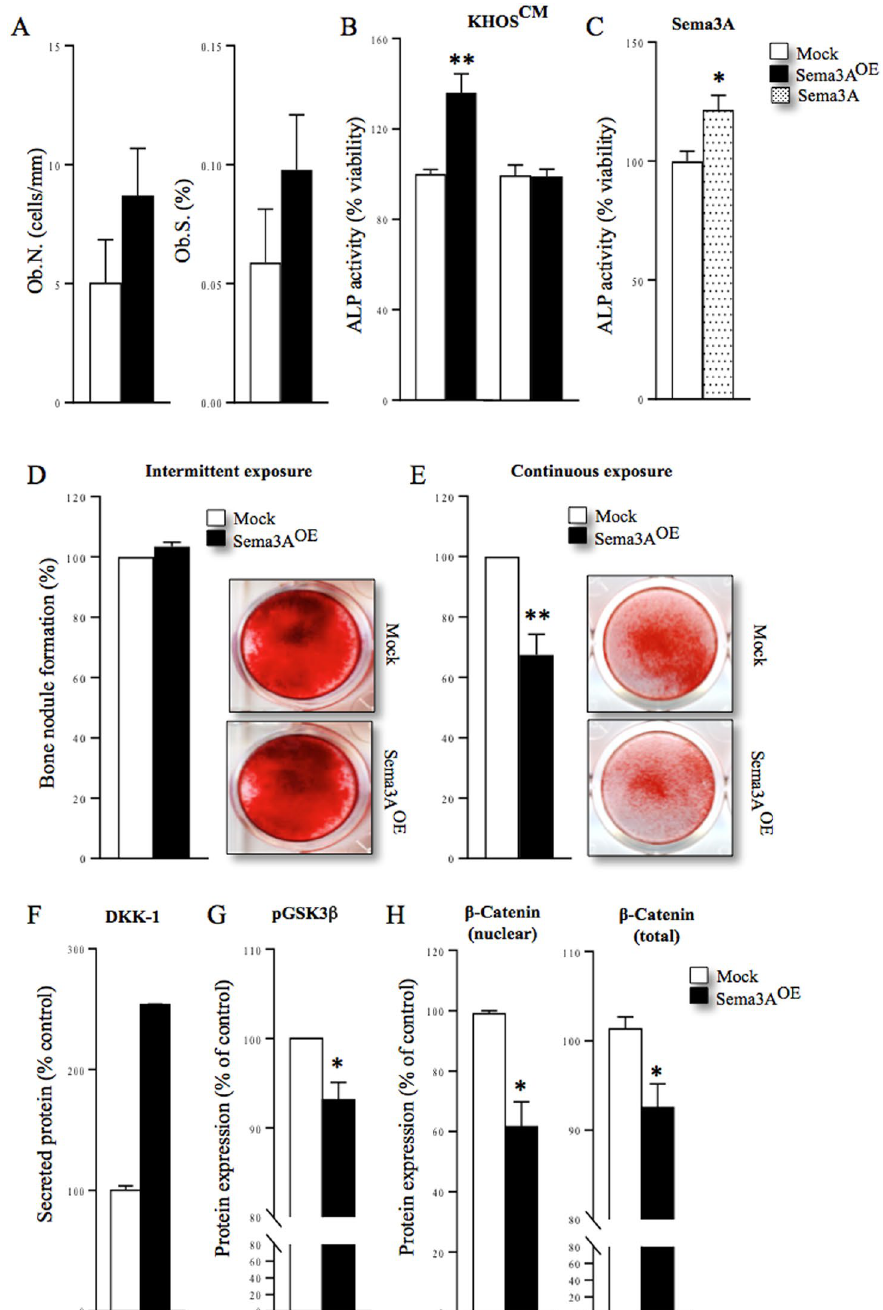
Figure 4. Bidirectional regulation of osteoblast differentiation by Sema3A. ( A ) In vivo osteoblast number (Ob.N) from tibial metaphysis from the mice of the experiment described in Fig. 3. ( B , C ) In vitro differentiation of Saos-2 after intermittent ( B , left) and continuous ( B , right) exposure to conditioned medium from human KHOS cells overexpressing Sema3A (Sema3A OE ) or Sema3A (300 ng/ml, C ) as assessed by alkaline phosphatase assay. In vitro bone nodule formation in Saos-2 after intermittent ( D ) and continuous ( E ) exposure to conditioned medium from human KHOS cells overexpressing Sema3A (Sema3A OE ) or their respective controls as assessed by Alazarin Red. Representative photomicrographs of bone nodule formation from the experiments described are shown in the right. ( F ) Levels of tumour derived osteoblast inhibitory factor, DKK1 in conditioned medium from human KHOS cells overexpressing Sema3A (Sema3A OE ) or their respective control measured by the Proteome Profiler Human XL Cytokine Array Kit. ( G ) Differential expression of p-GSK3 β after 15 minutes in the osteoblast-like MC3T3 cells exposed to conditioned medium from human KHOS cells overexpressing Sema3A (KHOS OE ) or their respective control (mock). ( H ) Differential expression of nuclear β -catenin (left) after 45 minutes and total β -catenin (right) after 24 hours in the osteoblast-like MC3T3 cells exposed to conditioned medium from human KHOS cells overexpressing Sema3A (KHOS OE ) or their respective control (mock). Data are mean ± SEM, n = 3 * p < 0.05, ** p <